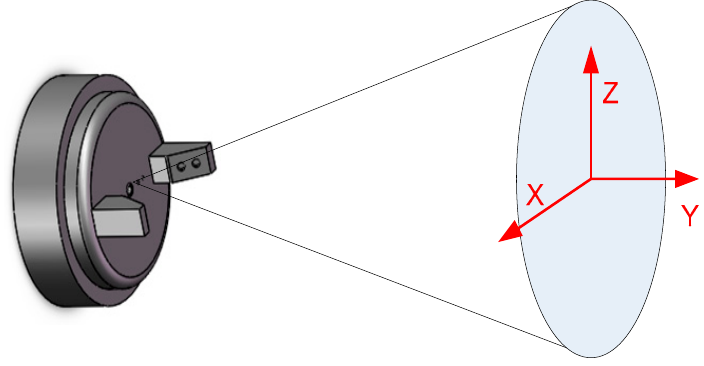
Figure 1. Schematic diagram of spray cone.